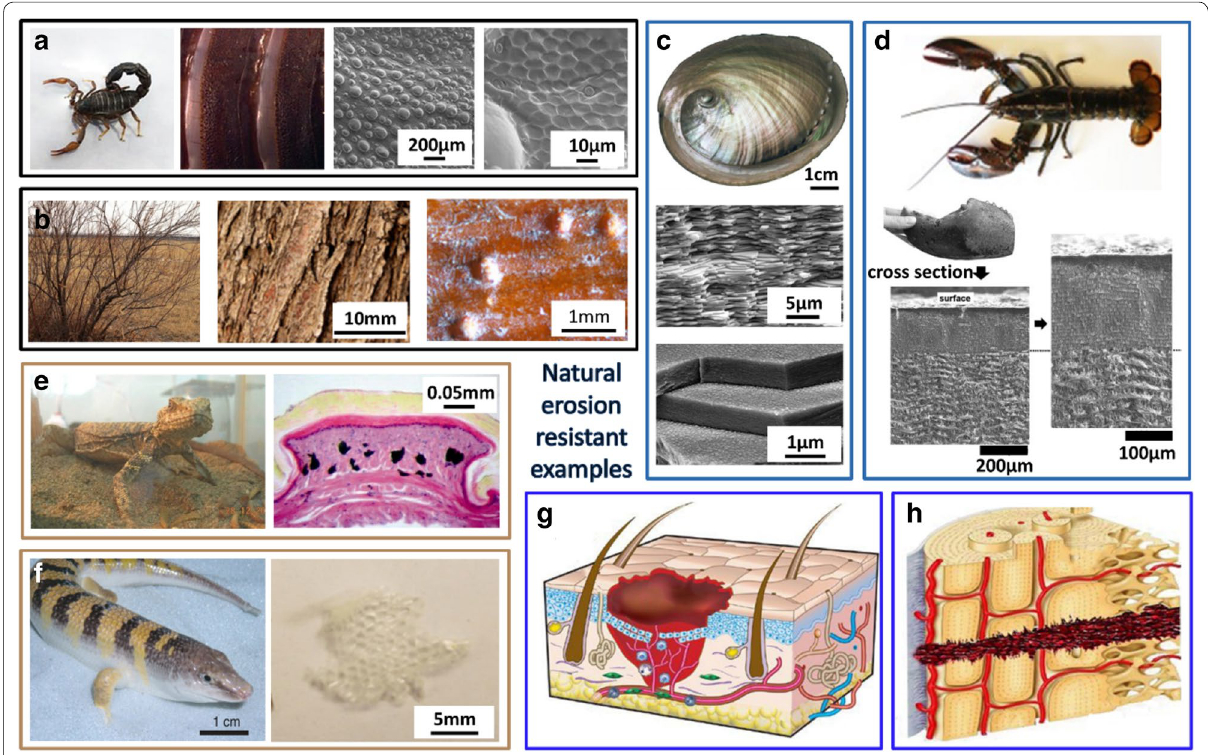
Figure 1 Different examples of natural resistance to solid particle erosion and the corresponding micro/nanostructures: ( a ) The armor of the desert scorpion ( Androctonus australis ) with special surface structures (curve, grooves, bumps and pits) has excellent erosion resistance [19]; ( b ) The tamarisk ( Tamarix chinensis ) can effectively resist sand erosion due to the special surface structures (curve, grooves and bumps) of the trunk surface [20]; ( c ) The layer-like nacre of a gastropod ( Haliotis laevigata ) assembled by aragonite platelets can reduce external impacts to protect the inner soft body [21]; ( d ) The lobster cuticle ( Homarus americanus ) with the twisted plywood structure exhibits excellent mechanical properties [22, 23]; ( e ) The desert lizard skin ( Laudakin stoliczkana ) can be used for preventing erosion from sand and have a hard layer and a soft layer in their buffered structure (Image of desert lizard provided by He Huang) [24]; ( f ) The sandfish skin ( Scincus scincus ) is durable [25, 26]; ( g ) Schematic illustration of the self-healing process of skin [27]; ( h ) Schematic illustration of the self-healing process of bone